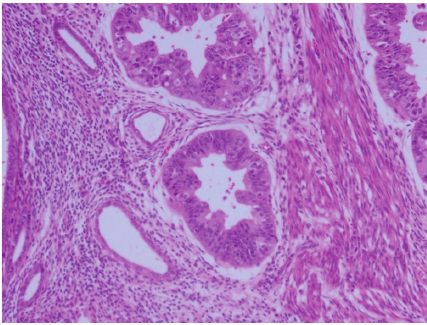
Figure 3: (H.E. × 100). Endometrioid adenocarcinoma adjacent to the adenomyotic foci was